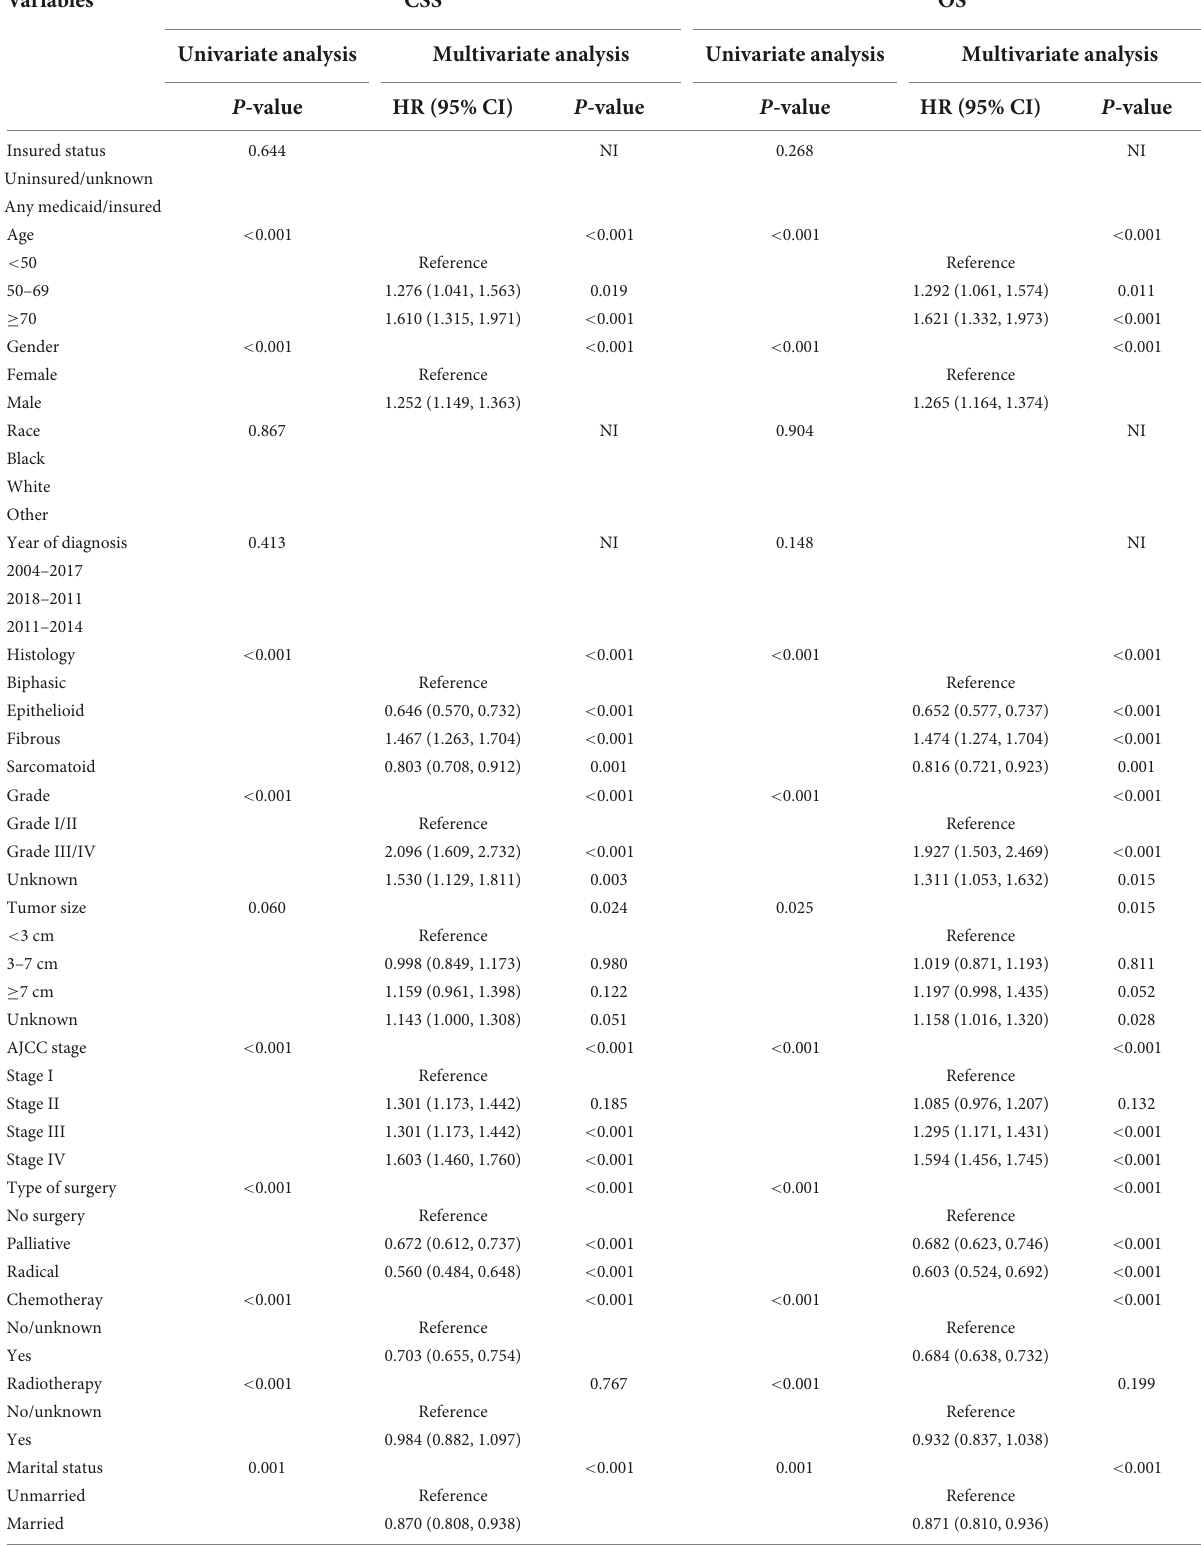
TABLE 2 Univariate and multivariate analyses of cancer special survival (CSS) and overall survival (OS) for patients with MPM. Variables CSS OS Univariate analysis Multivariate